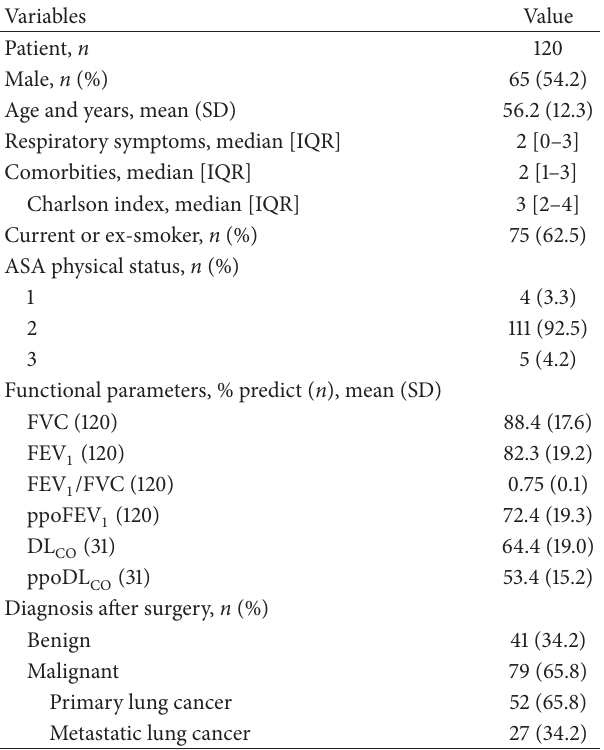
Table 1: Characteristics of patients included in the study. Table 2: Comparison of effective use of ICU group ineffective use of ICU group